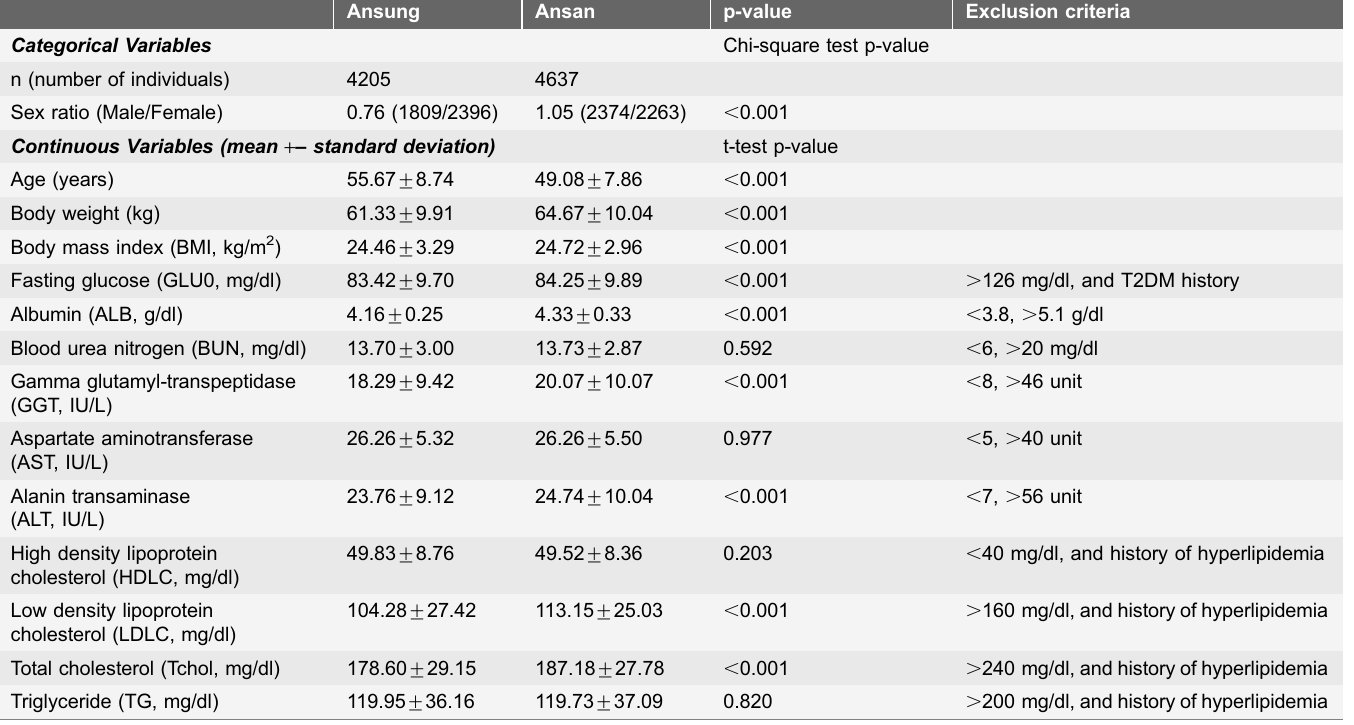
Table 1. Clinical characteristics of the Ansung and Ansan cohorts and the exclusion criteria for each biochemical